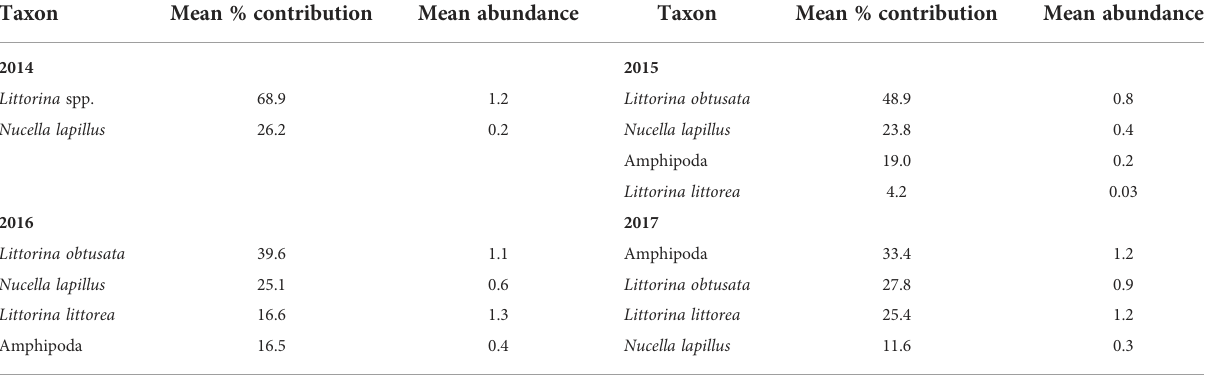
TABLE 4 Summary results of SIMPER analyses for mobile species, indicating the mean percent contribution to similarity in species composition among locations (see Materials and Methods for details) and the mean abundance (individuals dm -2 ) across all locations for each surveyed year. For brevity, only the species with the highest contribution are shown (those amounting to a cumulative contribution of 90%). Taxon